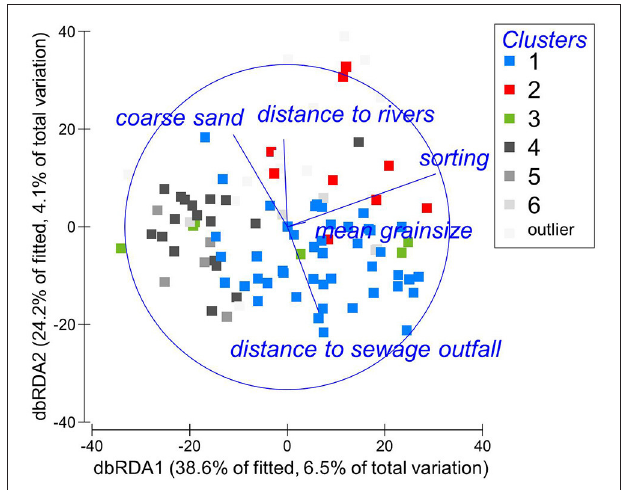
FIGURE 4 | dbRDA ordination of the fitted model for the benthic community of Swansea Bay, based on Bray-Curtis similarities after ln(x + 1) transformation of abundances. Habitat characteristics significantly linked to the variation in the data are superimposed.